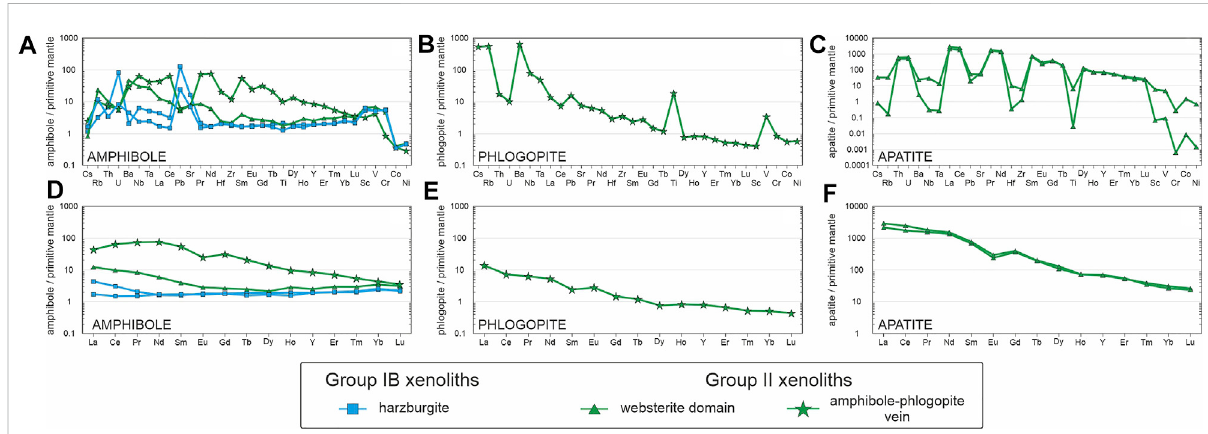
FIGURE 7 Primitive mantle (McDonough and Sun, 1995) normalized multi-element (A – C) and REY diagrams (D – F) for amphibole, phlogopite and apatite of MSZK